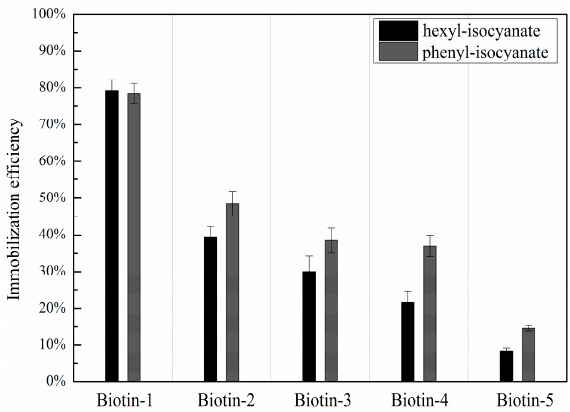
Figure 5. Immobilization efficiencies of five biotinylated compounds with different nucleophilic residues printed on hexyl-isocyanate surface vs. those printed on phenyl-isocyanate surface. The compound microarrays were both treated with pyridine vapor catalyzation at room temperature.